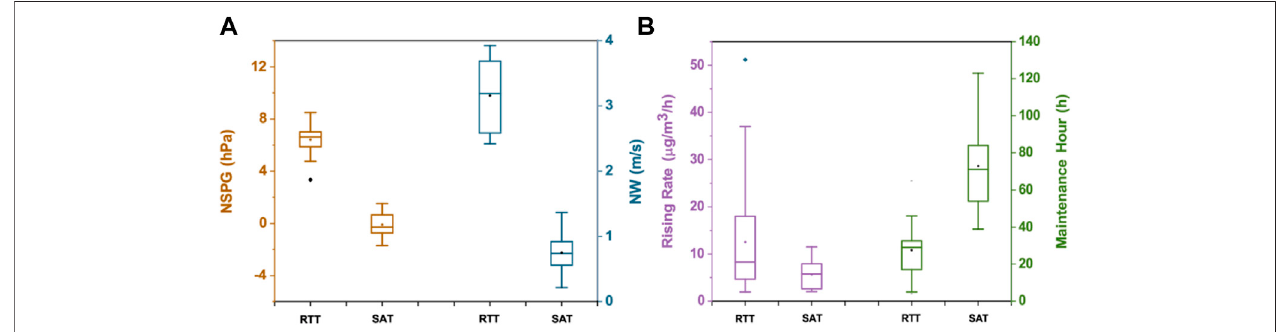
FIGURE2|(A) BoxplotoftheNSPR(left) andNW (right)ofsixepisodes forRTTandtwelve episodes forSAT; (B) boxplot oftherising rateofPM 2.5 concentrations (left)andtimeduration(right)ofseverePM